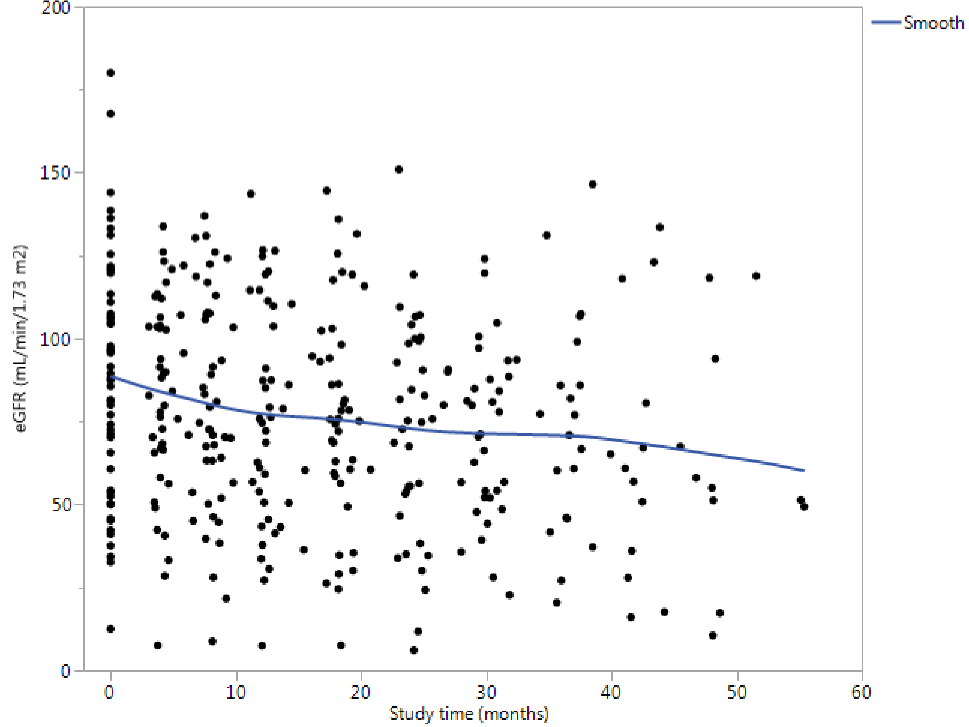
Fig 2. Time-course of change in eGFR over follow-up. All eGFR values used in the analysis are plotted and a smoothed curve fitted to the entire cohort to reflect overall time-related change in eGFR. The eGFR is fit to the study times using kernel density estimation (with λ = 0.77). The linear fit slope is -3.36 mL/min/1.73m 2